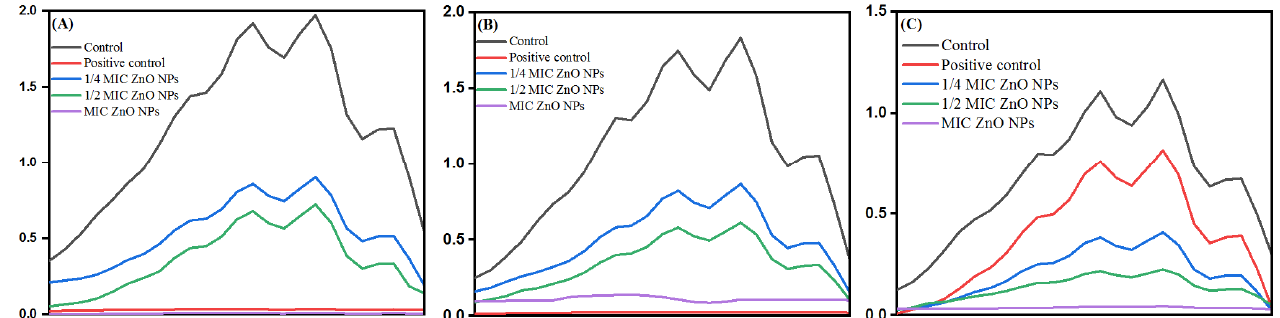
Figure 14. Effect of bio-fabricated ZnONPs on ergosterol levels in a laboratory strain C. albicans SC5314 ( A ), fluconazole-susceptible C. albicans 4175 ( B ), and fluconazole-resistant C. albicans 5112 ( C ) at MIC and sub-MIC. Untreated cells and cells treated with 8 µ g/mL of fluconazole represent negative and positive controls, respectively. Table 5. Effect on the ergosterol biosynthesis in C. albicans SC5314, fluconazole-susceptible C. albicans 4175, and fluconazole- resistant C. albicans 5112 strain after treatment with different concentrations of ZnONPs.